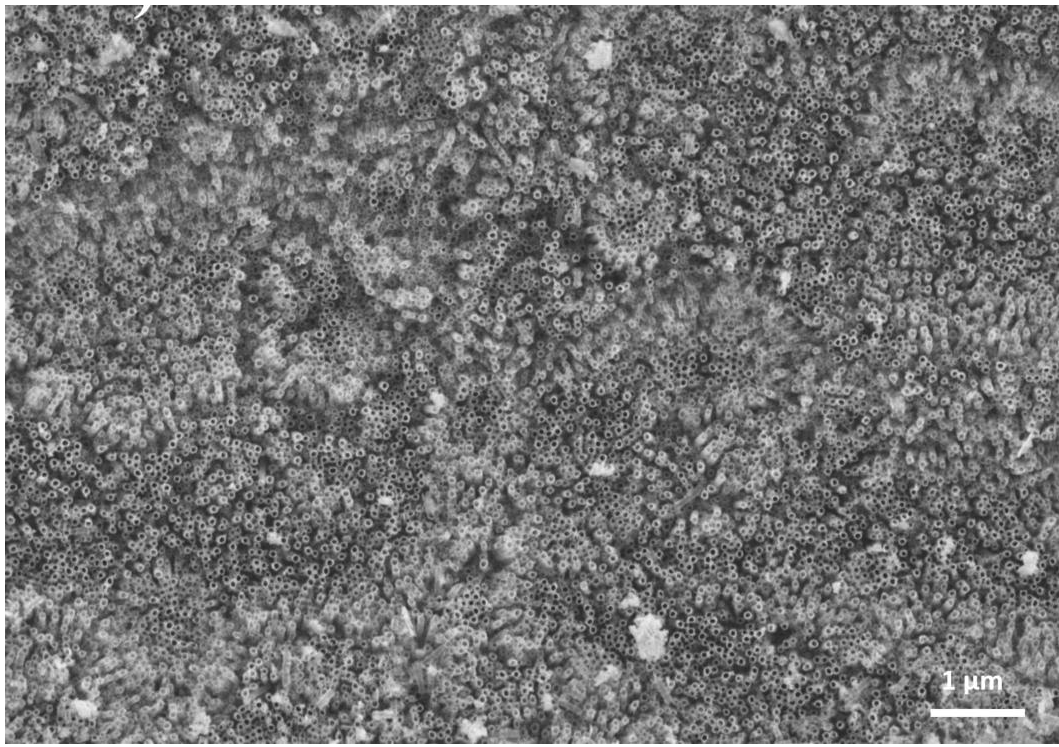
Figure 2. The Field Emission Scanning Electron Microscopy (FESEM) image surface topography of the Ti35Nb10Ta alloy after the anodic oxidation process. Table 3. Surface chemical composition obtained with Energy Dispersive Spectroscopy (EDX).